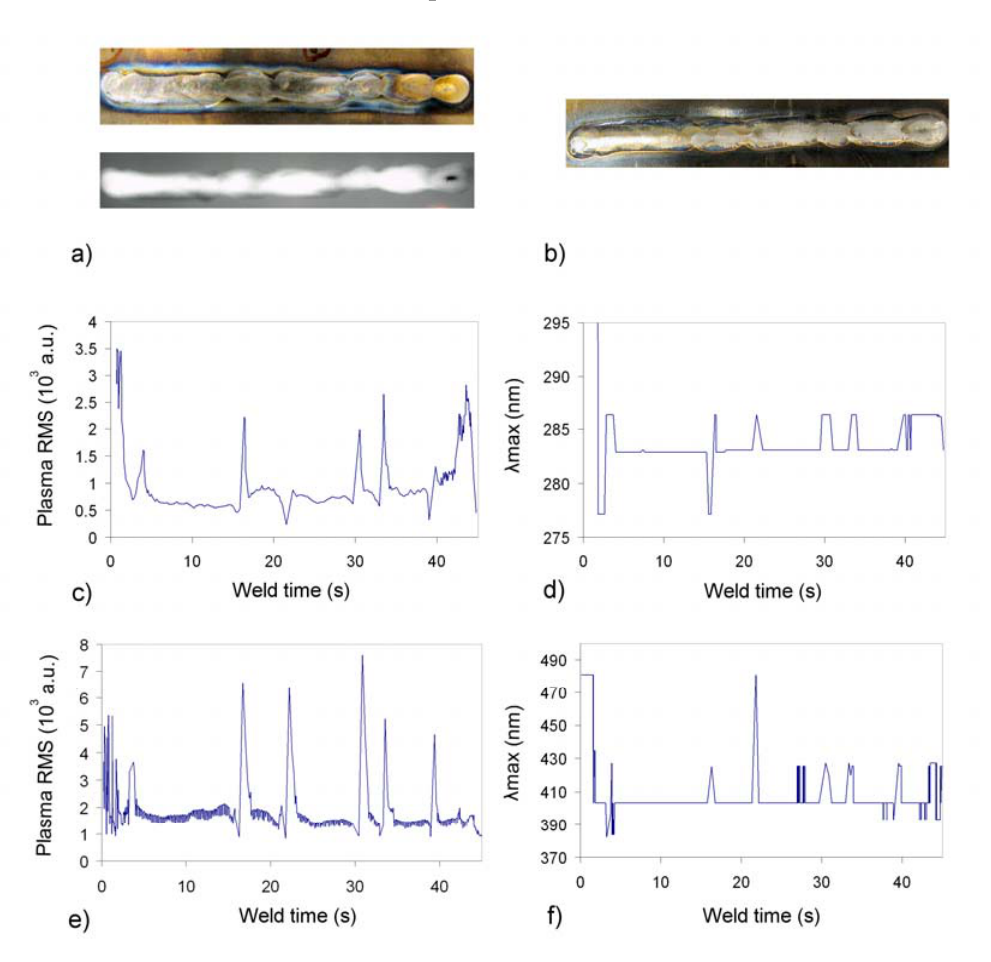
Figure 3. Plasma RMS and λ